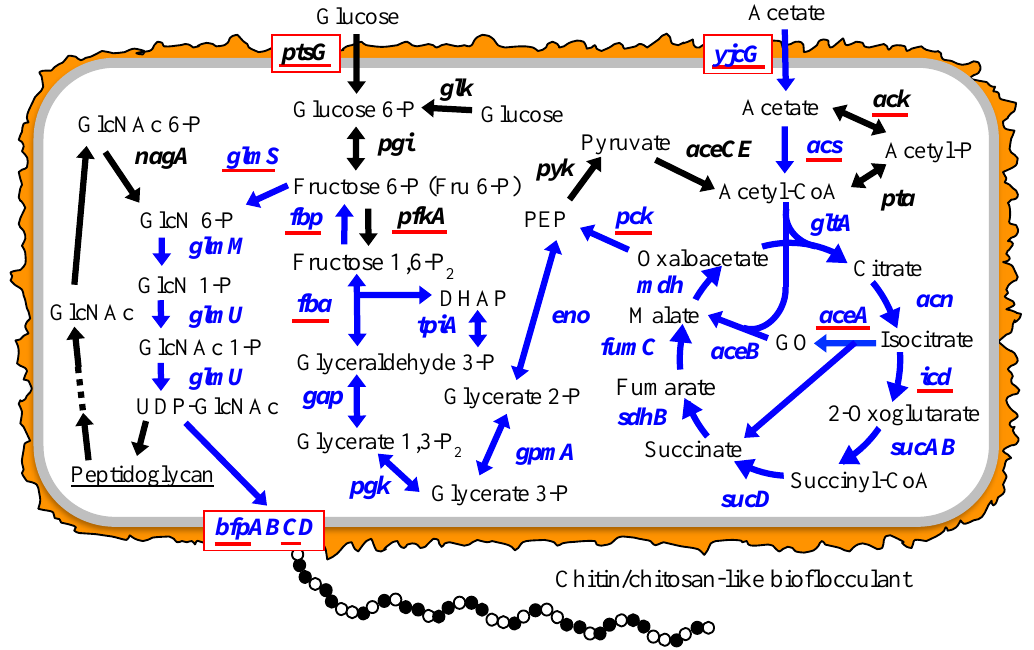
Figure 1. Proposed bioflocculant (BF) synthetic pathway and the genes of Citrobacter freundii IFO 13545 involved in the pathway. Blue arrows and gene names indicate the proposed BF synthetic pathway and the genes encoding the enzymes involved in this pathway. The genes underlined in red were used in a qRT-PCR study to determine the level of gene expression in glucose medium (GM) and in acetate medium (AM). Abbreviations: BF, bioflocculant; GO, glyoxylate; P, phosphate; P 2 , diphosphate; DHAP, dihyroxyacetone-P; PEP, phosphoenolpyruvate; GlcN, glucosamine; GlcNAc, N -acetylglucosamine. Table 1. Accession numbers of the registered genes in Citrobacter freundii IFO 13545. Accession